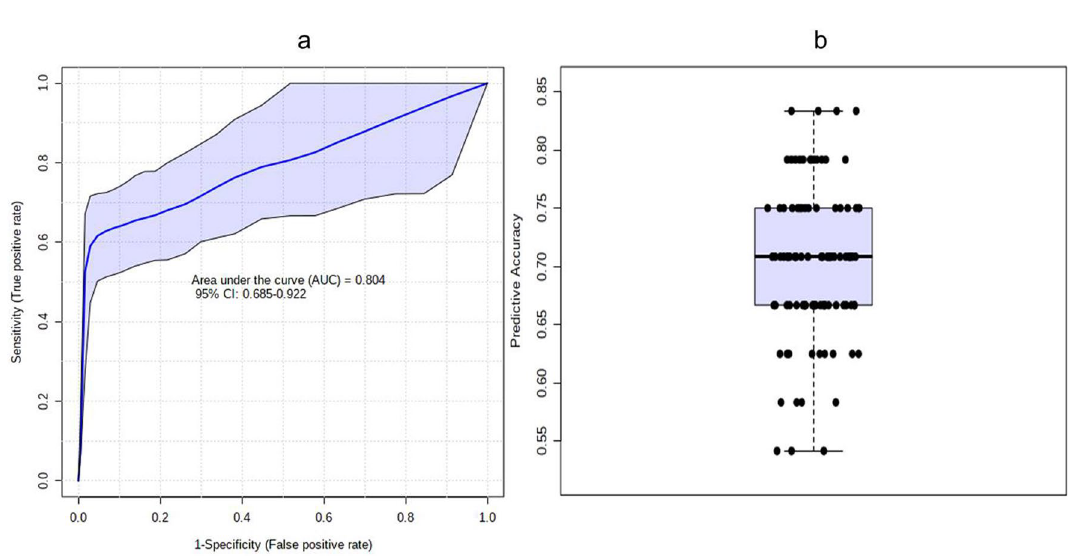
Figure 9. ( a ) The predictive ability of the combination of Anthranilate, 3-Hydroxykynurenine, and Tyrosine based on ROC AUC values along with with Sensitivity and Specificity at 95% CI. ( b ) The average predictive accuracy of the metabolite combination based on 100 cross